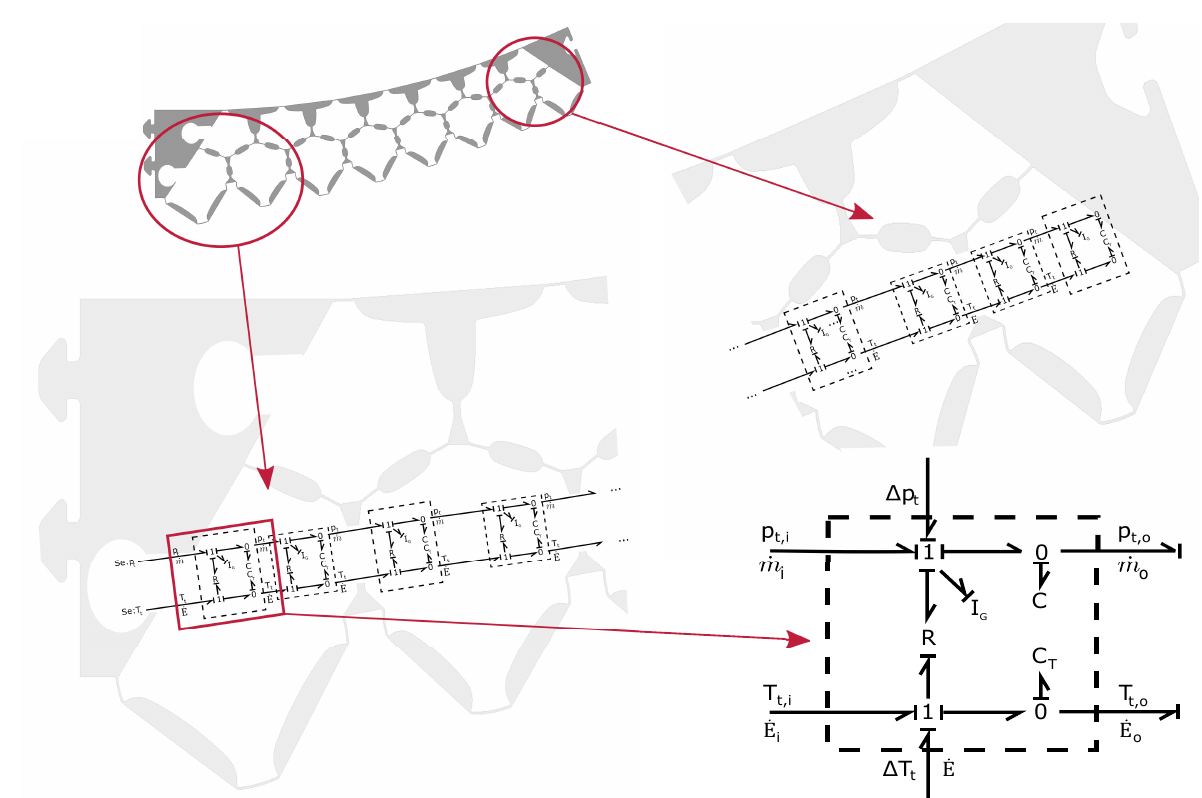
Figure 5. Schematic drawing of the internal flow of a PACS structure in Pseudo Bond Graph